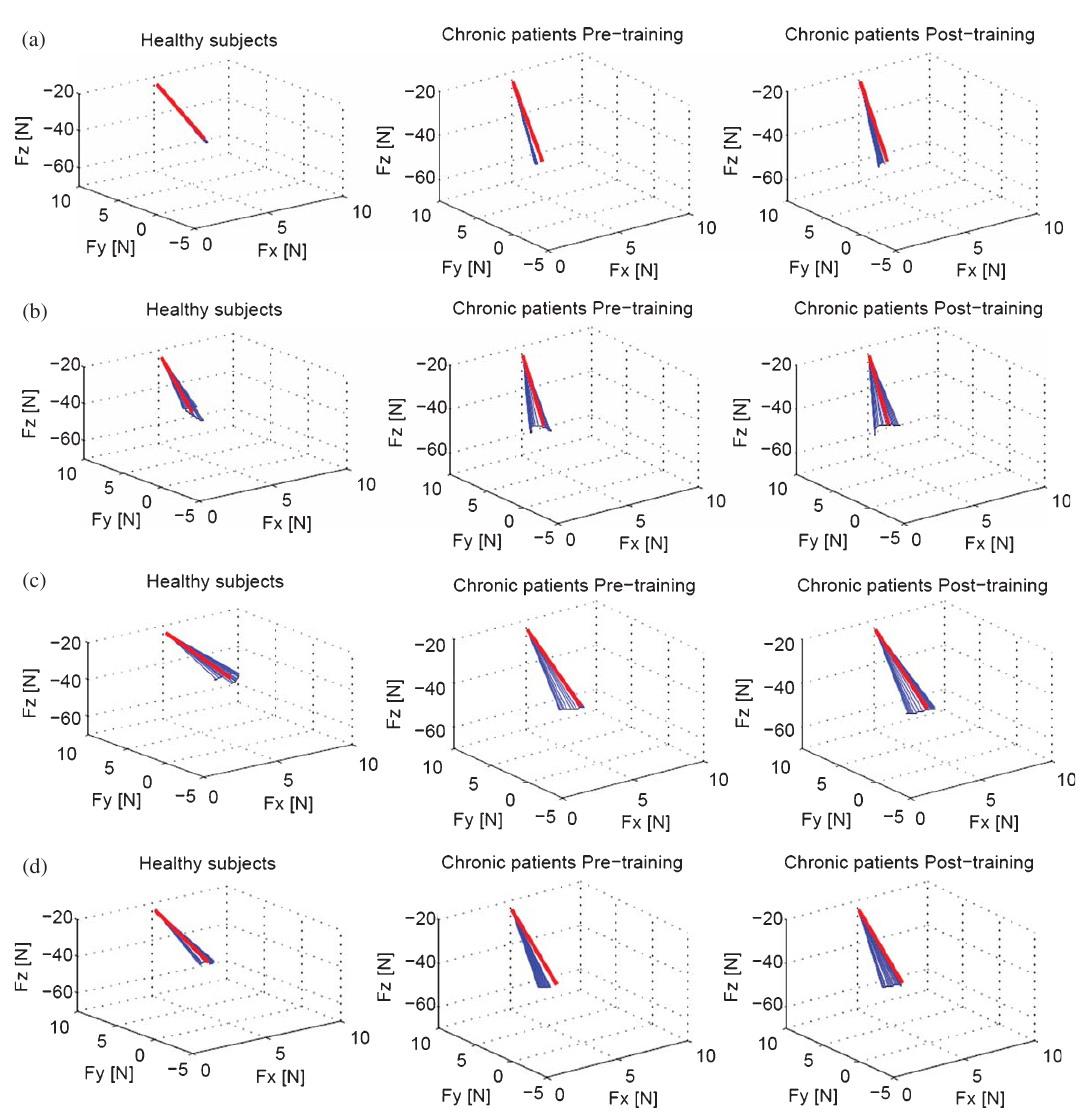
Fig. 6. Deviations from the mean force vector in healthy subjects and in a post-stroke patients: direction N t (a), direction S b (b), direction W b (c), direction E t